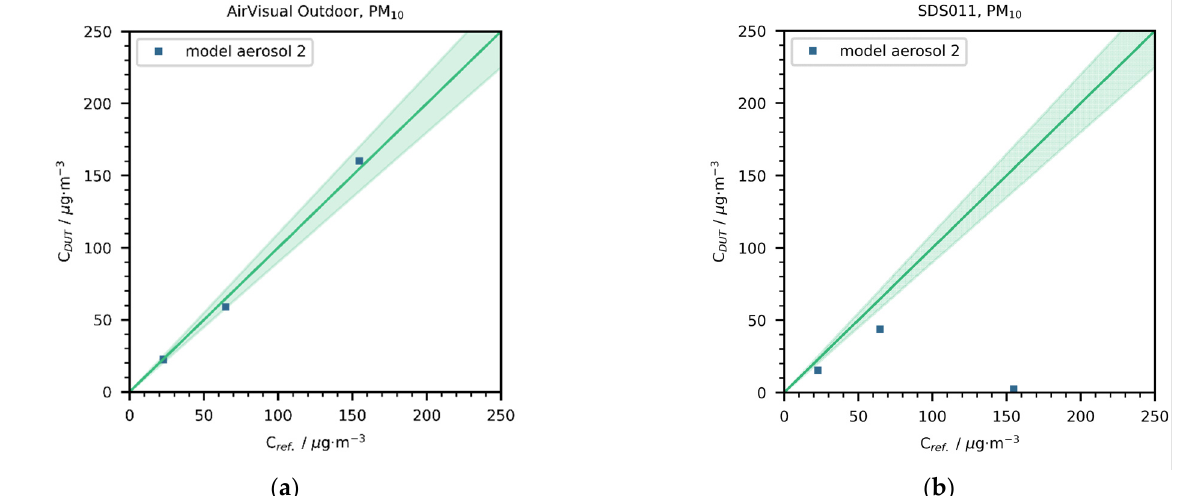
Figure 6. PM 10 mass concentrations reported by ( a ) the AirVisual Outdoor and ( b ) the SDS011 versus the gravimetric reference mass concentration. The green line denotes a perfect agreement, while the shaded green area designates a maximum 10% relative expanded uncertainty ( k = 2; 95% confidence interval) of the gravimetric reference method. Table 2. PM 10 mass concentrations reported by the DUT and the reference gravimetric method— C DUT and C ref. , respectively—and measurement efficiency of the DUT, E DUT . U denotes expanded uncertainties ( k = 2; 95% confidence interval); s is the standard deviation of the mean (i.e., σ √ , with n being the number of measurements). Model